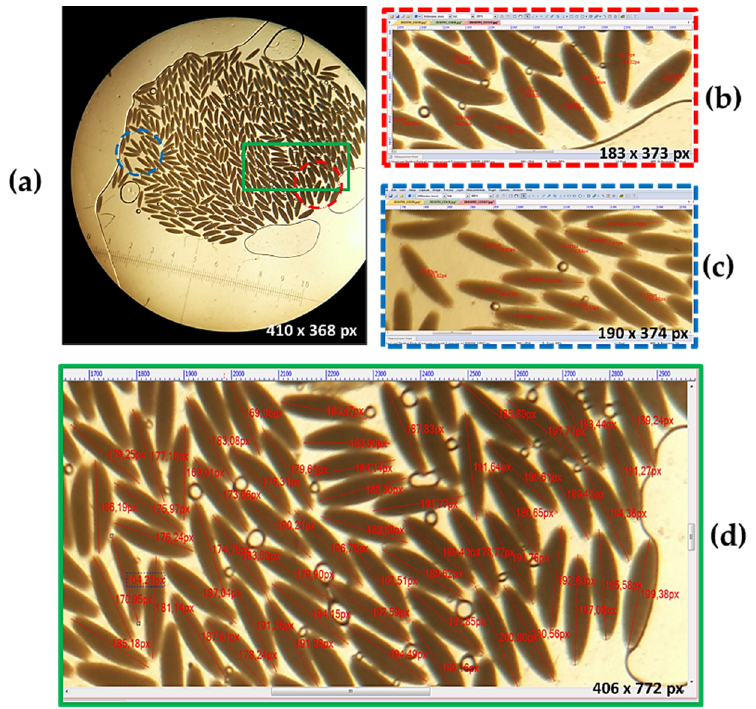
Figure 3. Variable egg sizes in different areas of the same clutch ( a ): egg with mean length of 0.889 mm and width of 0.232 mm ( b ); egg with mean length of 0.796 mm and width of 0.191 mm ( c ); egg with values of length and width intermediate between the two areas ( d ).